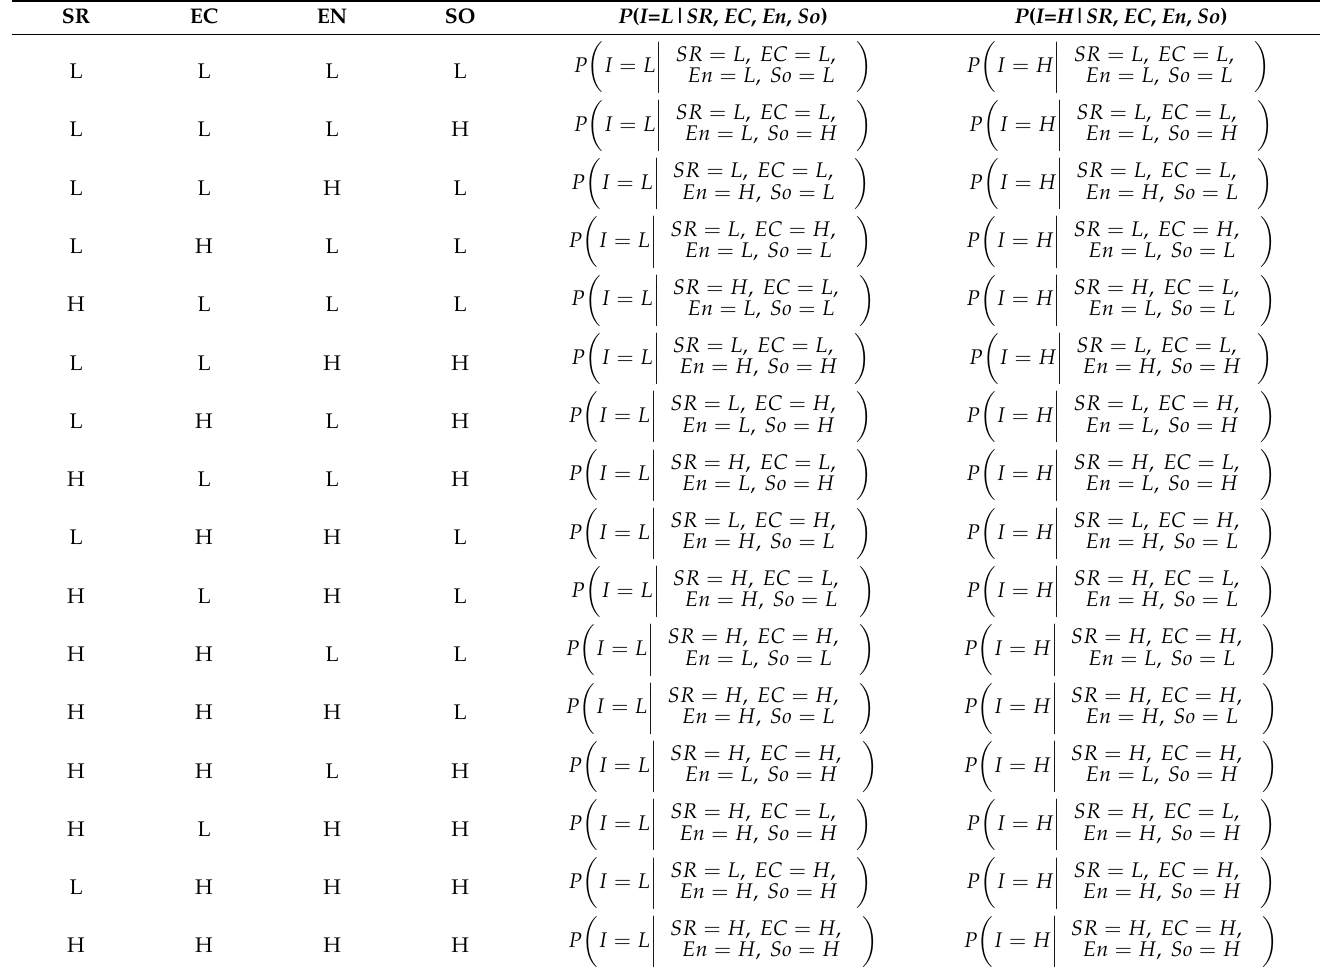
Table 15. Conditional probability table of the decision makers.